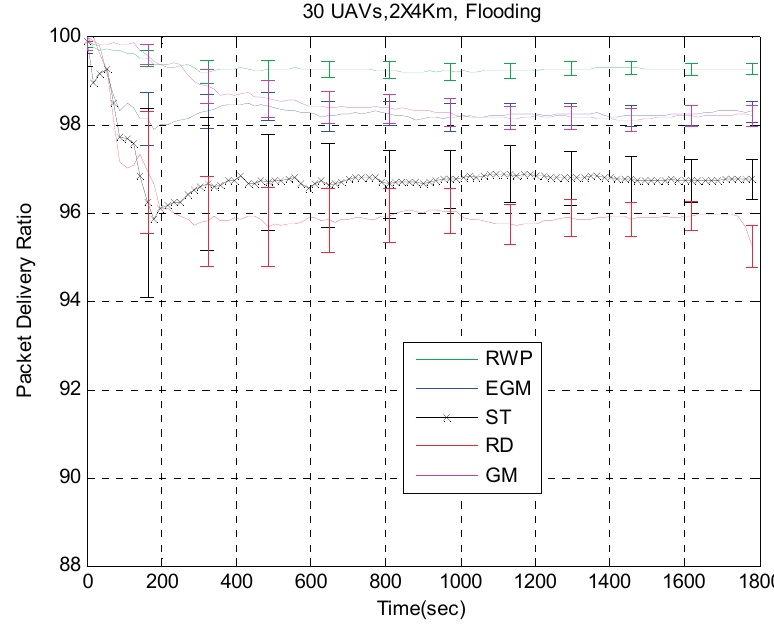
Figure 17. PDR of flooding under various mobility models.